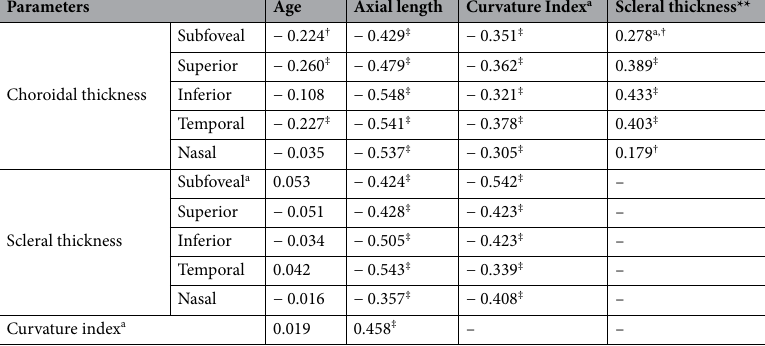
Table 3. Correlation coefficients for the associations of choroidal and scleral thicknesses with age, axial length, and curvature index. † P -value of correlation coefficient < 0.01. ‡ P -value of correlation coefficient < 0.001. a Excluded eyes with dome-shaped